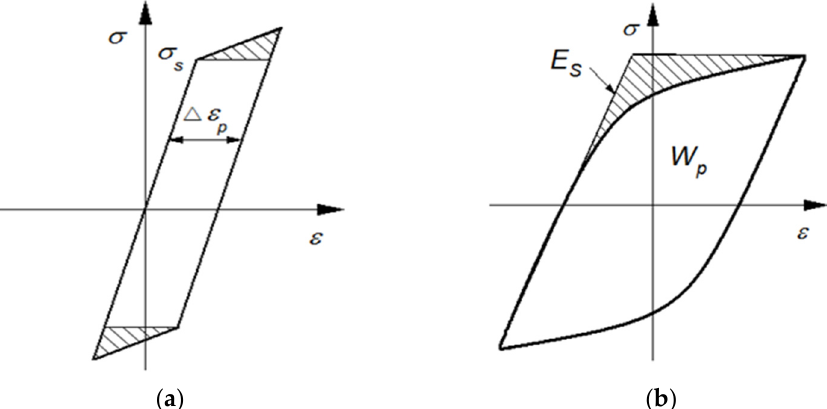
Figure 2. Stored energy models based on the stress–strain relation: ( a ) stored energy associated with working hardening; ( b ) stored energy connected with residual stress.